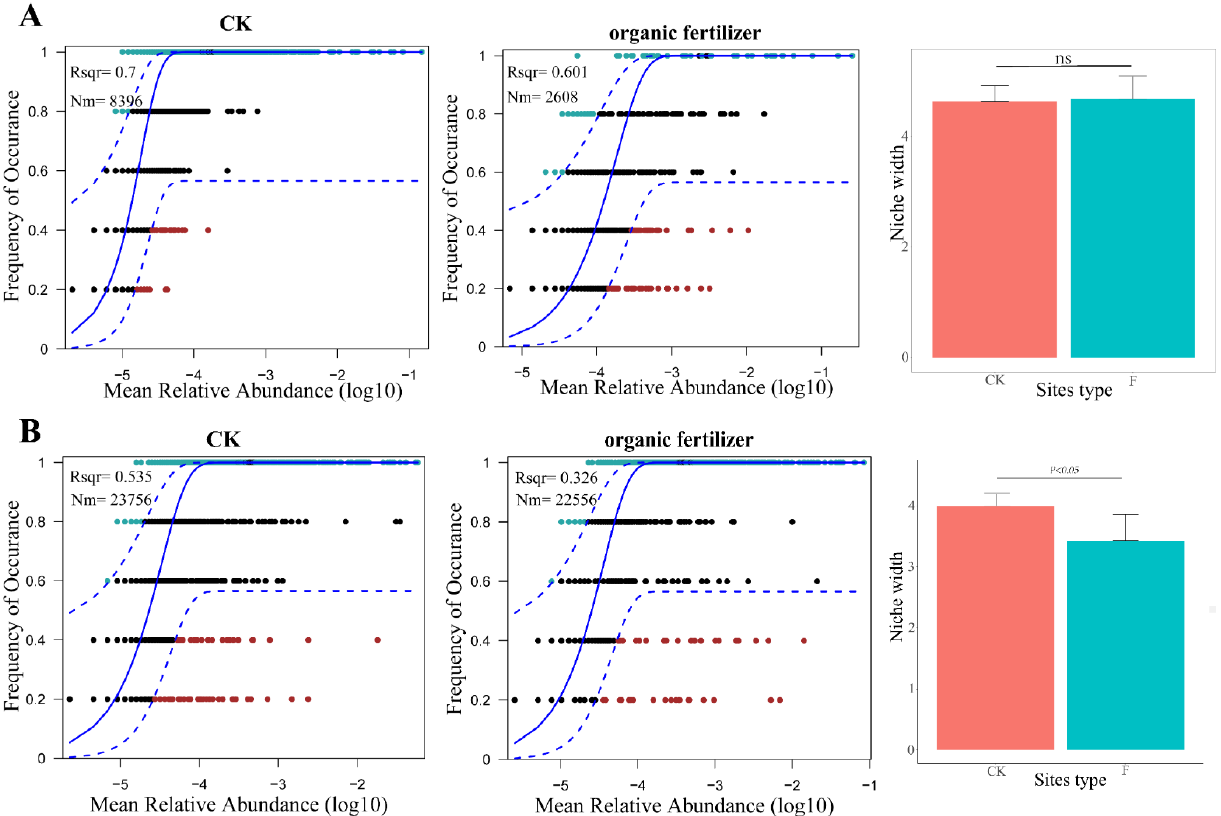
Figure 4. Neutral community model for bacteria ( A ) and fungi ( B ), NCM analysis. R 2 represents the overall goodness of fit of the neutral community model, with higher R 2 indicating that a closer model to neutral suggests that the construction of the community is more influenced by stochastic processes and less influenced by deterministic processes. Nm is the product of effective population size (N) and migration rate (m), quantifying the estimate of dispersal between communities and determining the correlation between frequency of occurrence and relative regional abundance. The solid blue line indicates the best-fit value of the neutral community model, the dashed blue line represents the 95% confidence interval of the model (estimated by 1000 bootstrap), and OTUs that occur more or less frequently than predicted by the neutral community model are shown in different colors. Eco-niche width comparison between treatments. ns indicates that the difference is not sig- nificant.